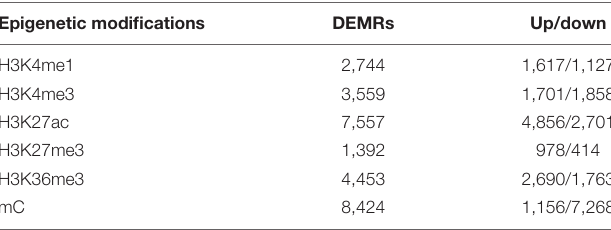
TABLE 1 | Counts of differentially epigenetic modified regions (DEMRs) for six types of epigenetic modifications in